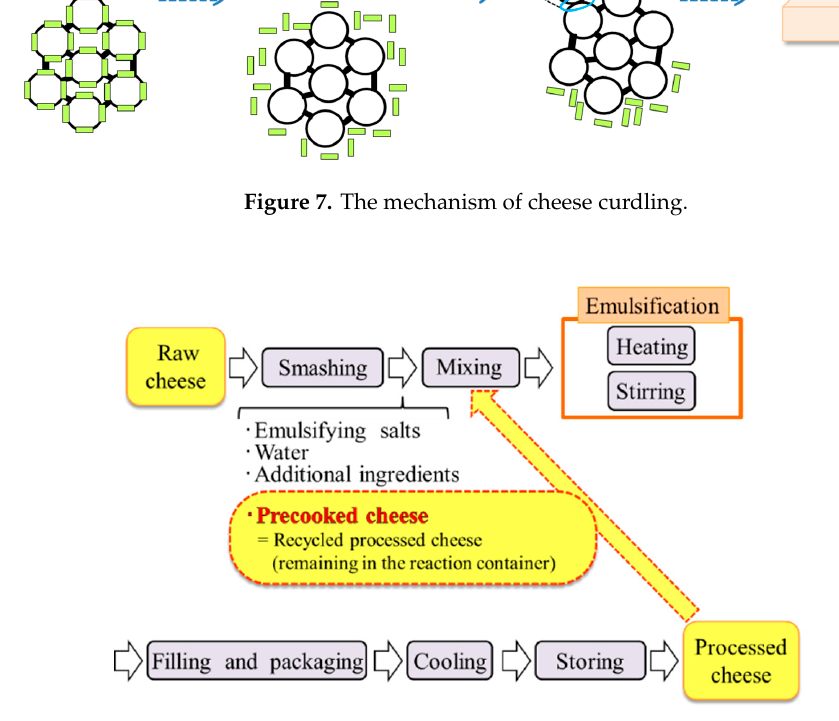
Figure 8. Preparation of processed cheese.